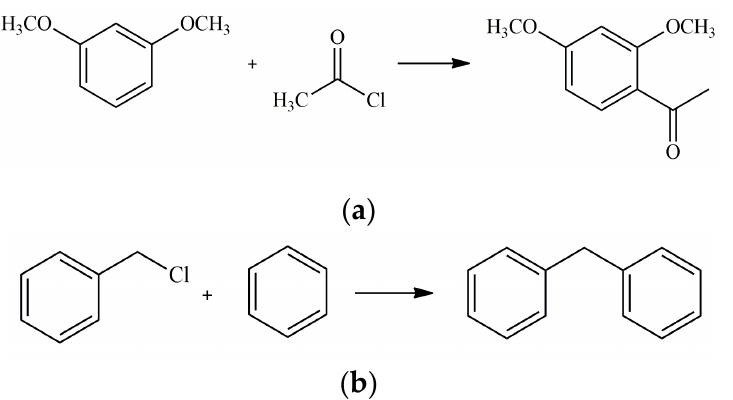
Figure 4. Friedel–Crafts acylation and alkylation reactions as: ( a ) acylation of 1,3-dimethoxybenzene and acetyl chloride; ( b ) alkylation of benzene with benzyl chloride.